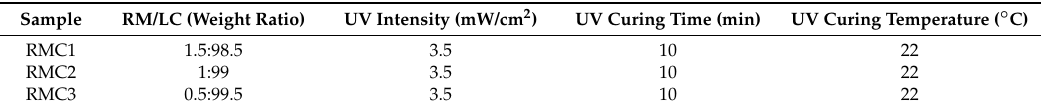
Table 1. When studying the RM concentration, mixtures of RM (Bis-MA) /LC (ZLI-4792) were prepared as below. In each mixture, the added amount of PI was 1% with respect to the RM.